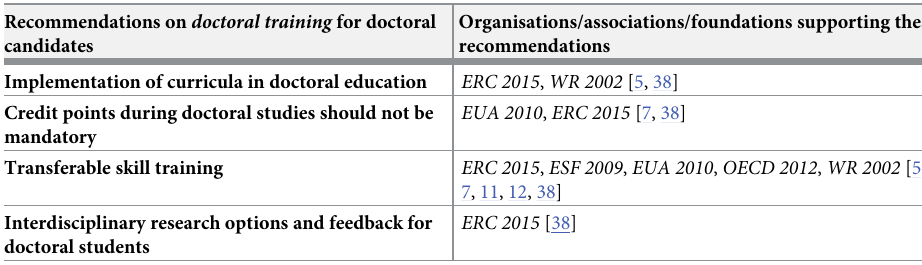
Table 7. Recommendations on doctoral training.